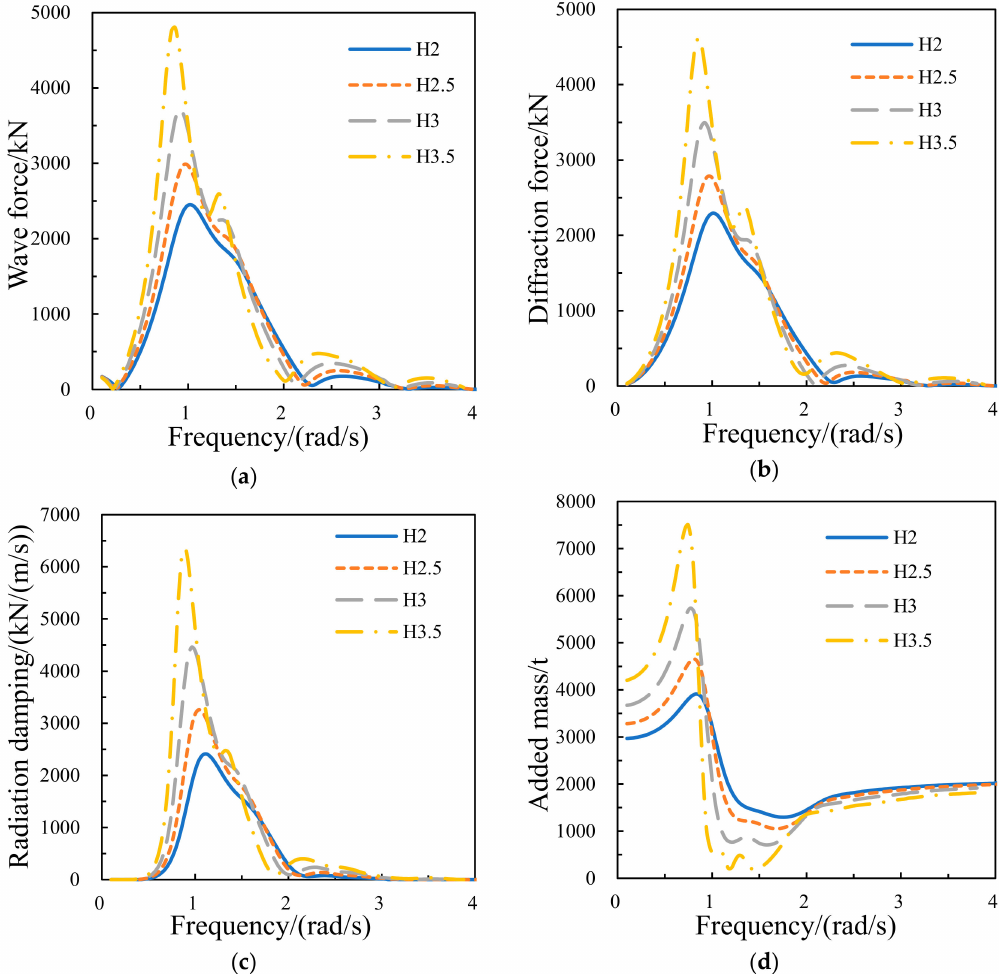
Figure 14. Four hydrodynamic parameter curves. ( a ) Wave force, ( b ) di ff raction force, ( c ) radiation damping, ( d ) added